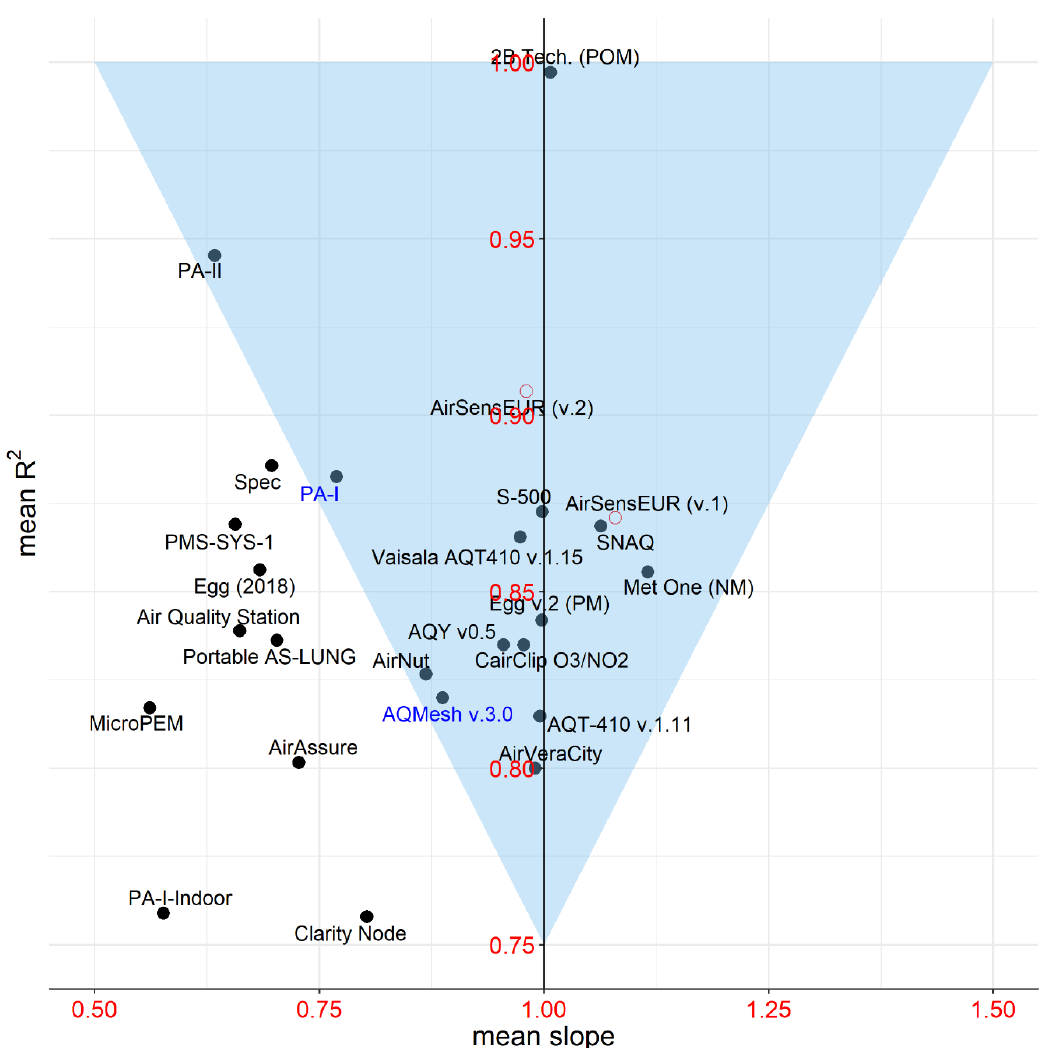
Figure 8. Correspondence between R 2 and slope for SSys. Only SSys models with R 2 > 0.75 and 0.5 < slope < 1.2 are shown. Names of “living” and “non-living” sensors are indicated in black and blue colors, respectively.